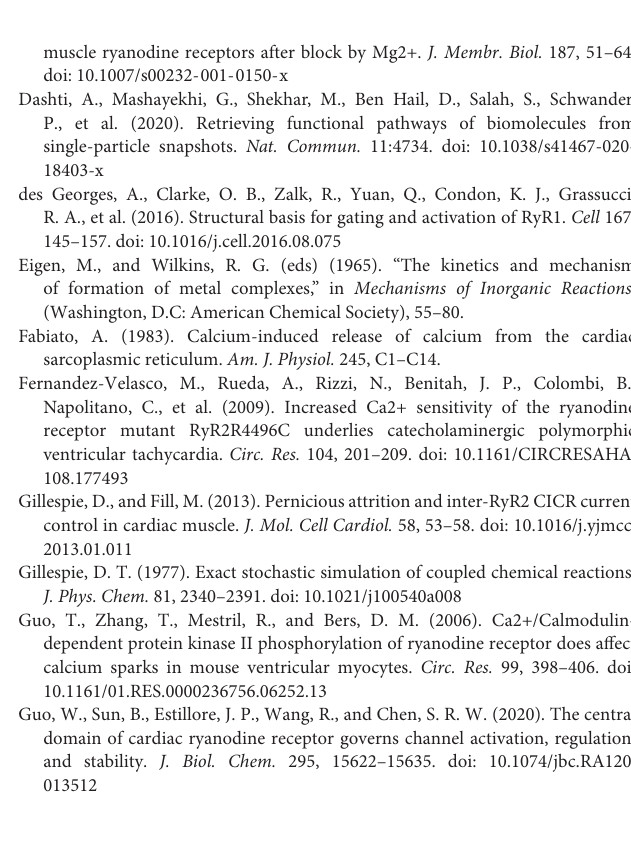
Table 1 . The values of Mg-binding parameters used in this study are given in Supplementary Table 2